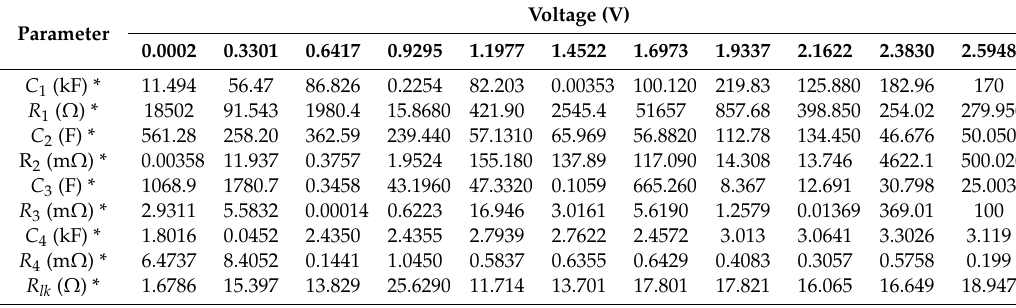
Table A5. Parallel Model Parameters with current profile i 2 .